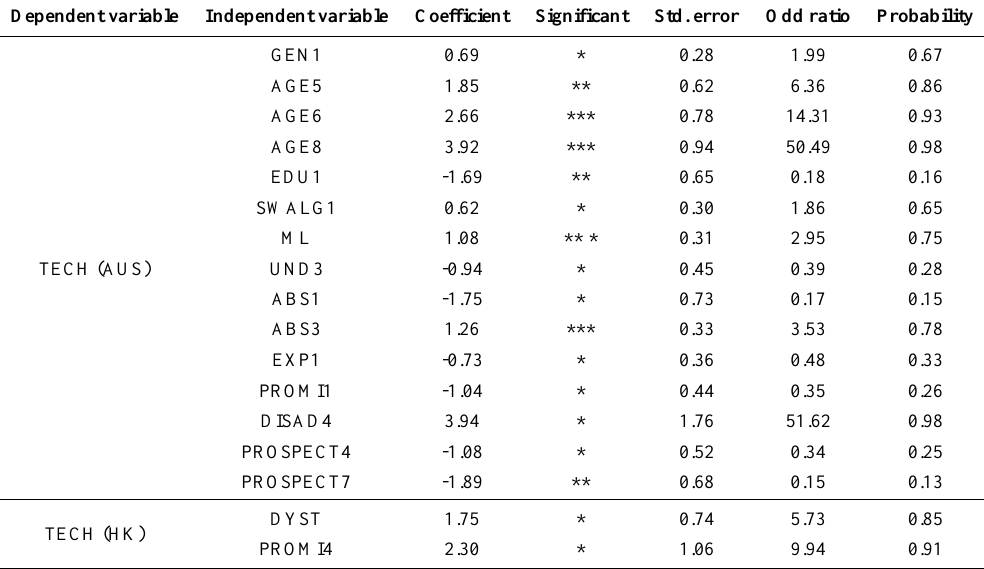
Table B-2. Limited technical local government staff and know-how on AI projects